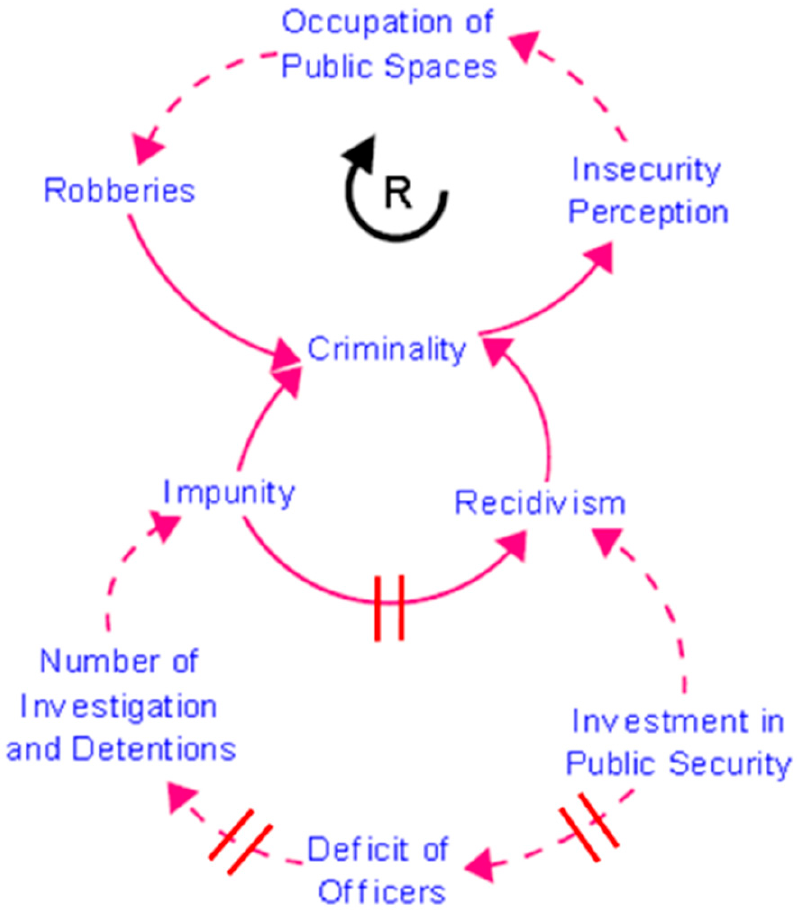
Figure 3. CLD of GQ2.